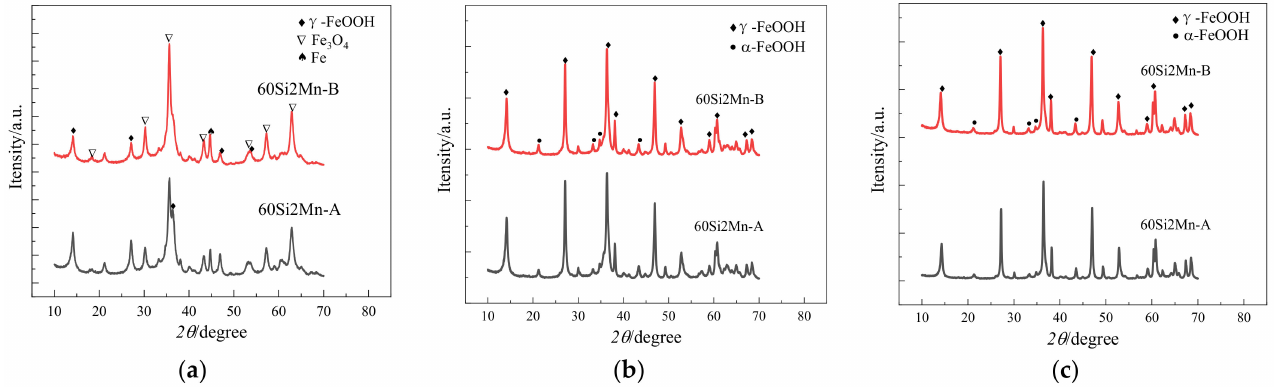
Figure 2. X-ray analysis of corrosion products of experimental steel after different corrosion time: ( a ) 24 h; ( b ) 72 h; and ( c ) 360